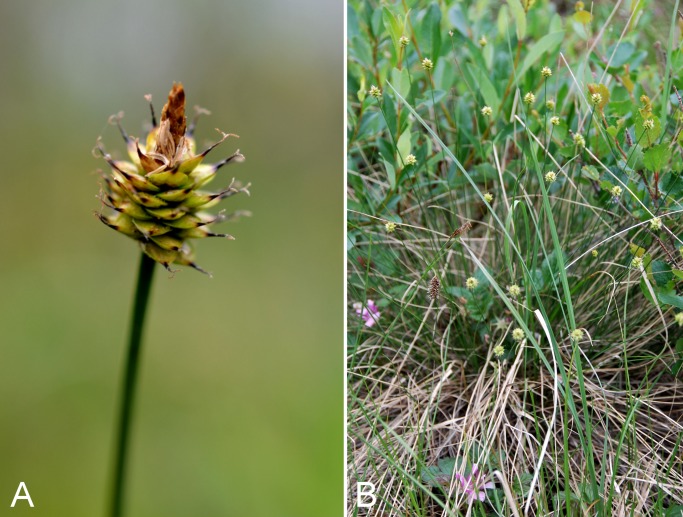
Carex capitata.(A) Inflorescence, Saarela et al. 3574. (B) Habit, Saarela et al. 3515. Photographs by P. C. Sokoloff (A) and J. M. Saarela (B).